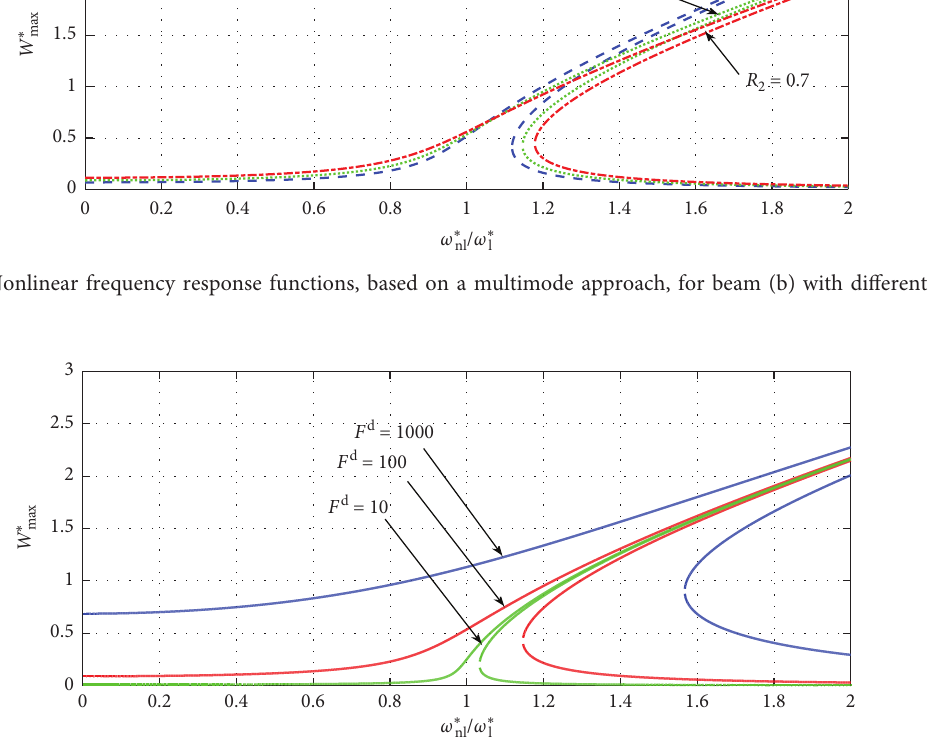
Figure 14: Nonlinear frequency response functions, based on a multimode approach, for beam (b) excited by different levels of distributed